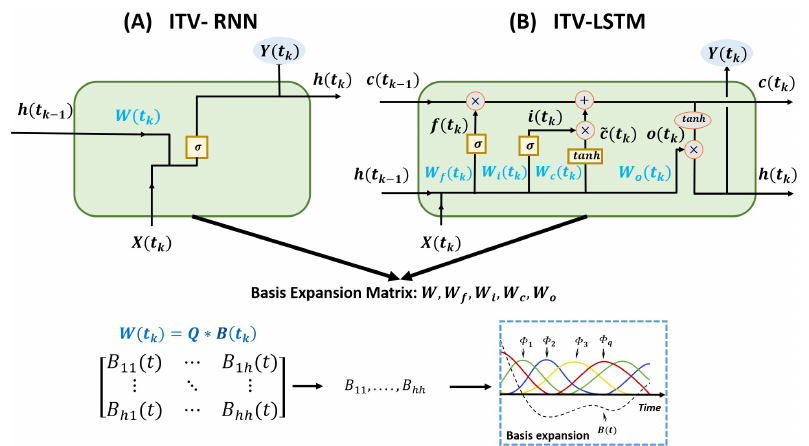
Figure 1. Internal time-varying models. The internal weights of RNN and LSTM cells are updated using the basis expansion